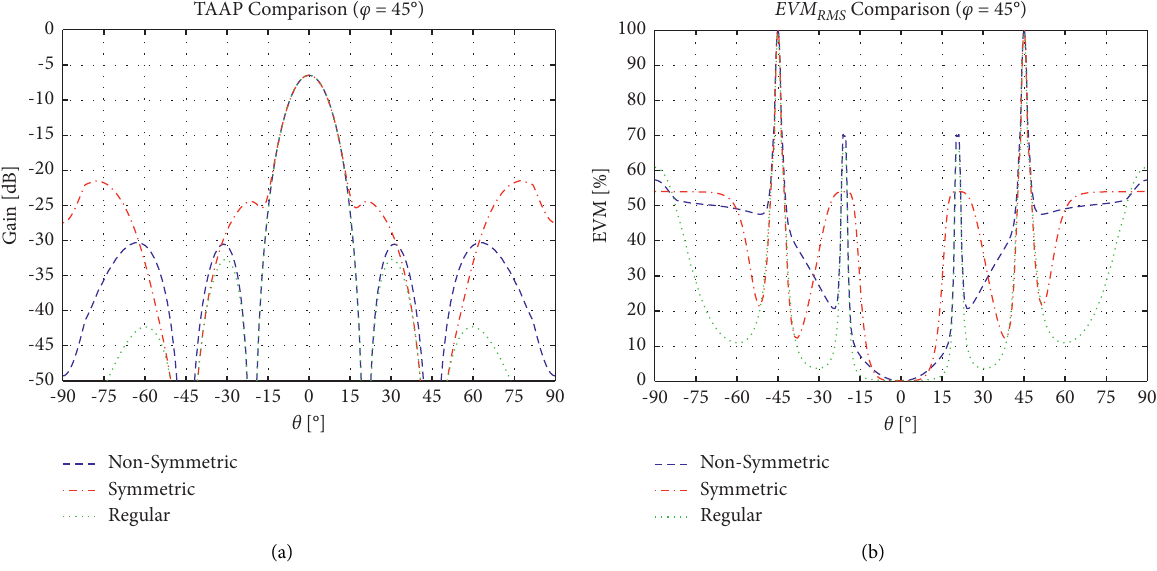
Figure 5: Symmetric outspacing array performance: K � L � 8, d element power pattern is used. (a) Array configuration. (b) Time average array pattern. (c) EVM.